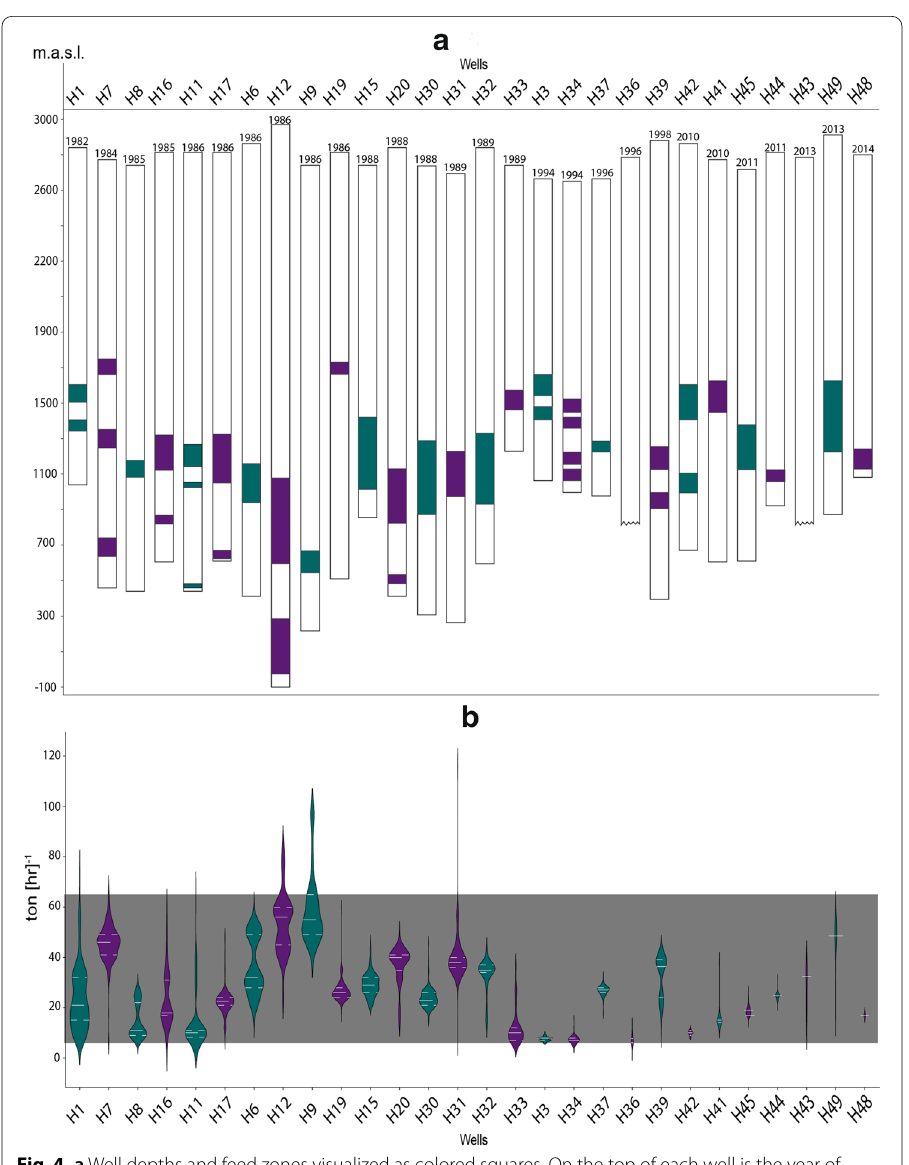
Fig. 4 a Well depths and feed zones visualized as colored squares. On the top of each well is the year of the first extraction record. b Violin chart showing the distribution of the production rates. The widths are proportional to the number of data points with the given flowrate. The median, Q1 and Q3 are presented by white lines. The gray block shows the range of the whole production. The bottom of the square is set by the Q1 of the less productive well. The top is set by the Q3 of the most productive